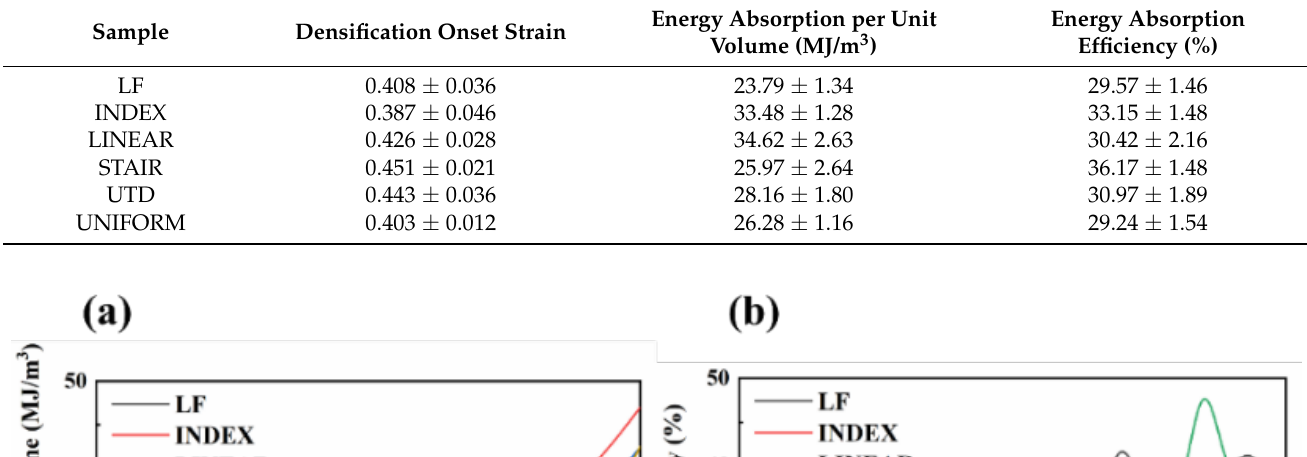
Table 4. Densification onset strain and energy absorption properties of different lattice structures.